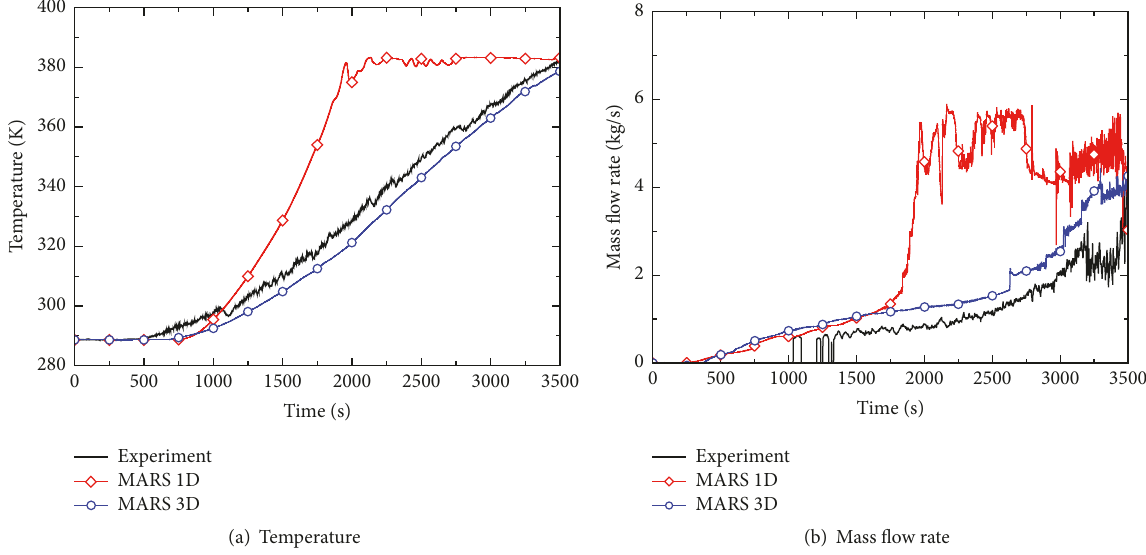
Figure 6: Mass flow rate and temperature at the inlet of the cooling channel.